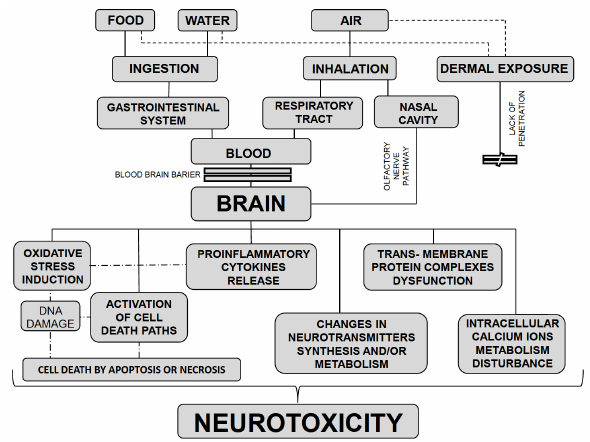
Figure 1: Mechanism of action of metallic nanoparticles in the cen- tral nervous